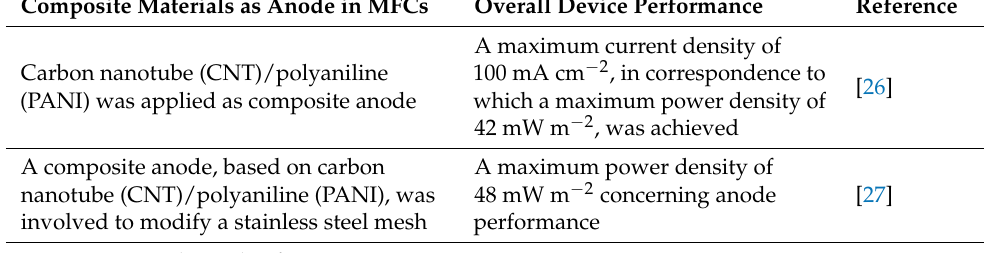
Table 1. Several composite anode electrodes based on CNT investigated in the literature and devel- oped as high-performing anode electrodes in microbial fuel cells (MFCs). Composite Materials as Anode in MFCs Overall Device Performance